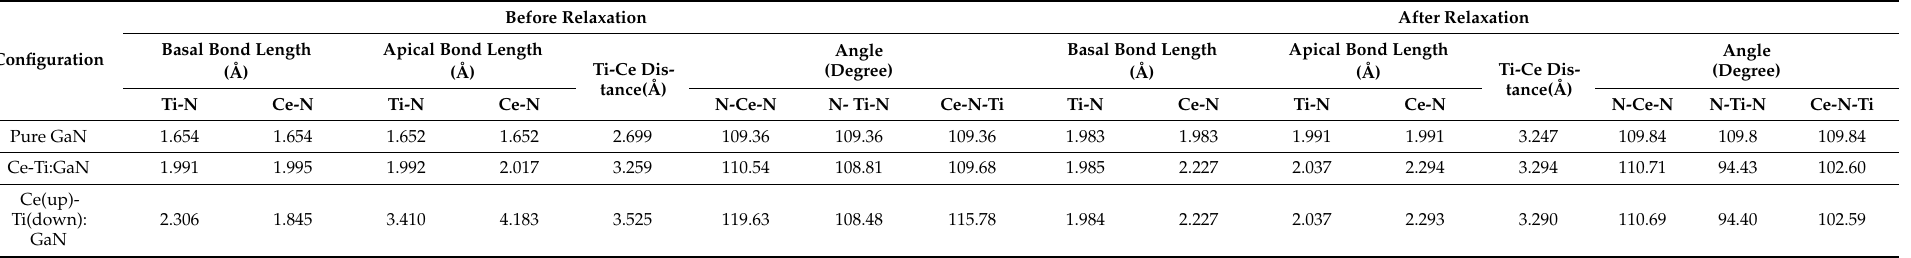
Table 5. Structural parameters of Ti-Ce codoped GaN before and after geometrical optimization.